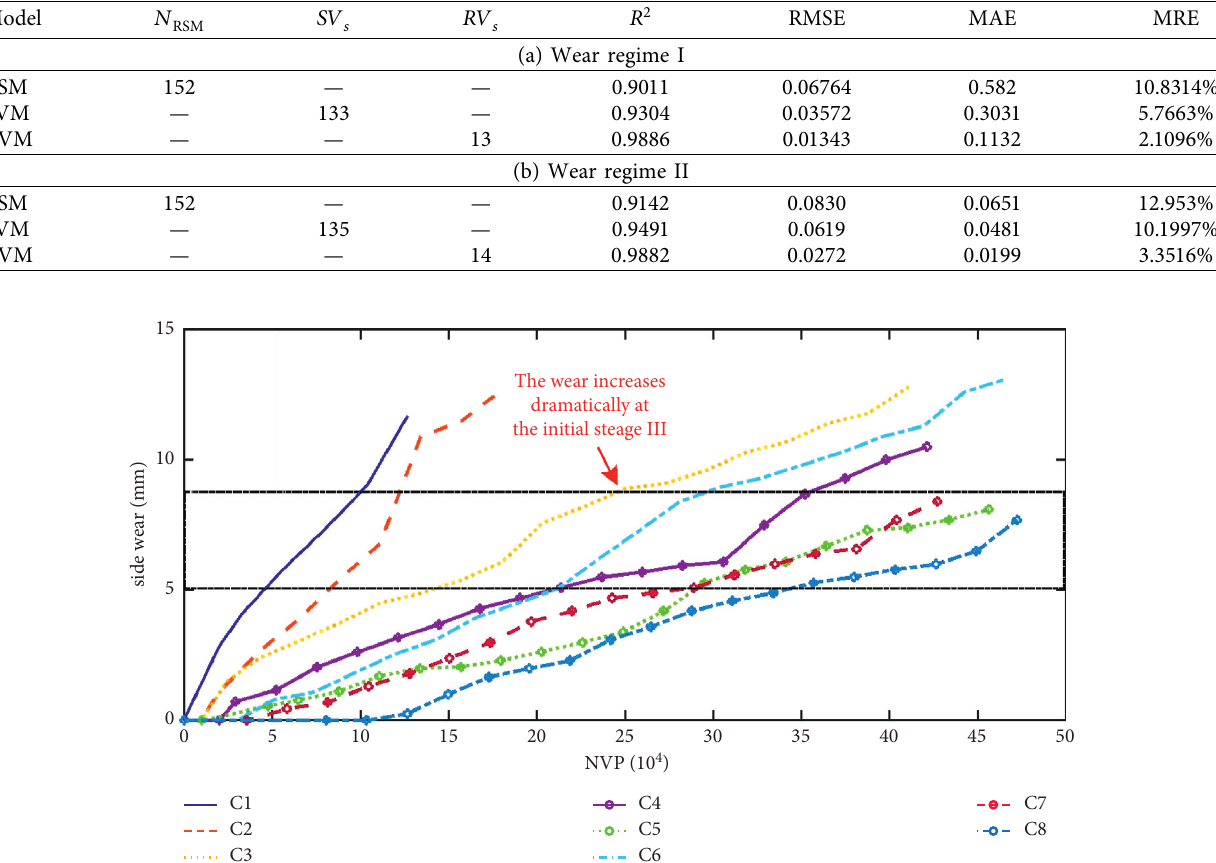
Figure 6: Development process of SRW in different railway